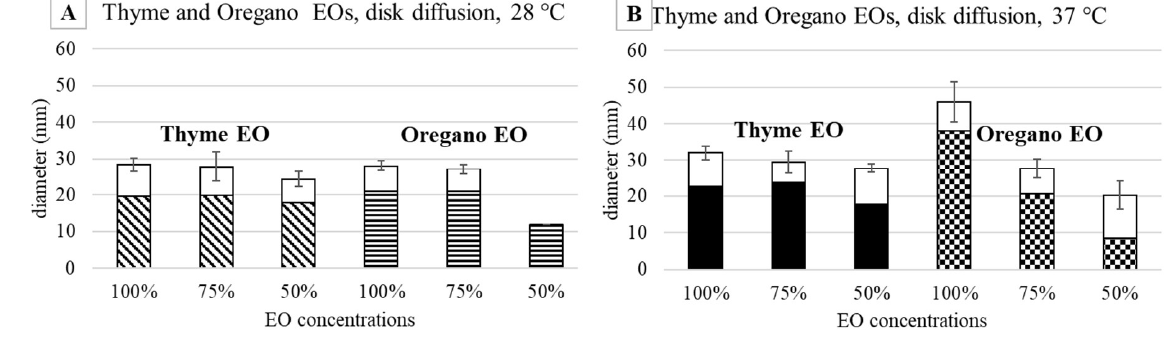
Figure 4. Agar diffusion test against E. coli incubated at 28 °C ( A ) and 37 °C ( B ): halo diameters measured after 48 h of incubation in the presence of thyme EO (oblique striped and black bars) and oregano EO (horizontal striped and checked bars). The white top portions of the bars represent the zones of faint bacterial growth.